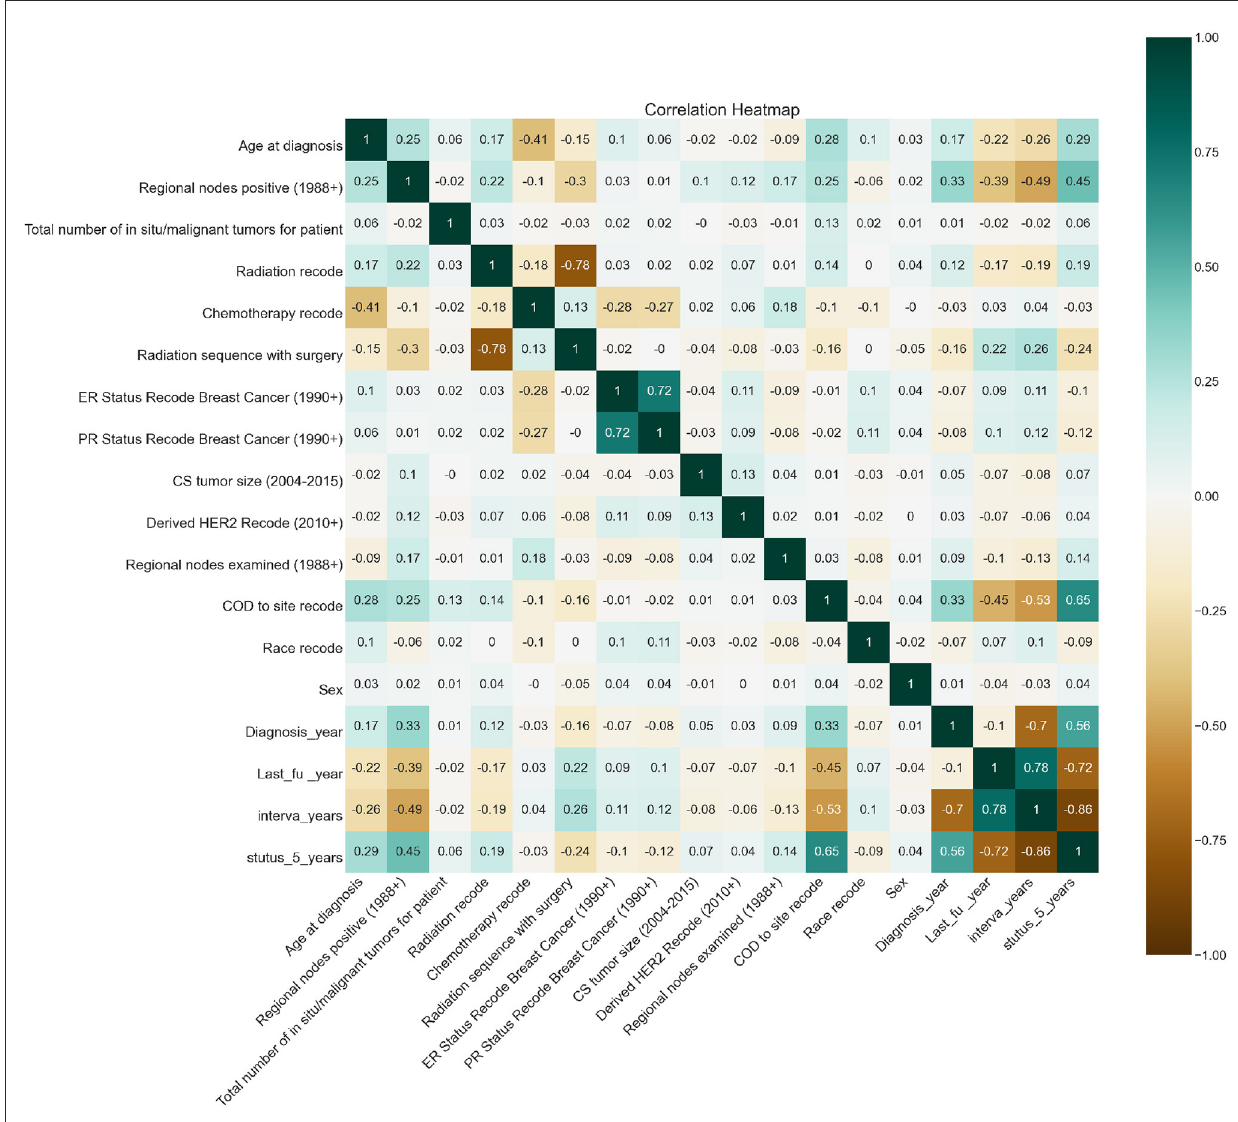
FIGURE3 Correlation